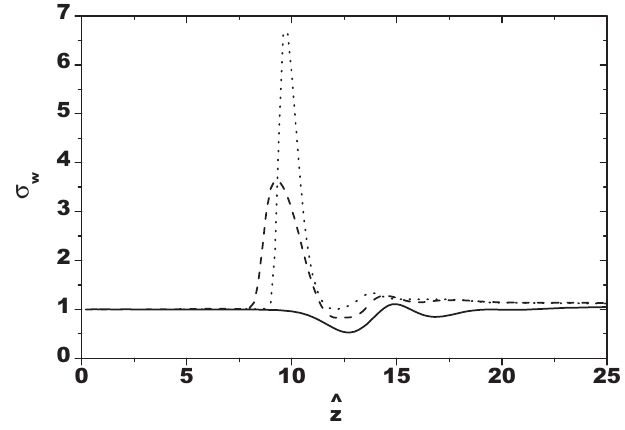
FIG. 6. Normalized rms deviation of the fluctuations of the instantaneous radiation power as a function of the normalized undulator length. Solid, dashed, and dotted lines correspond to the fundamental, 3rd, and 5th harmonic,